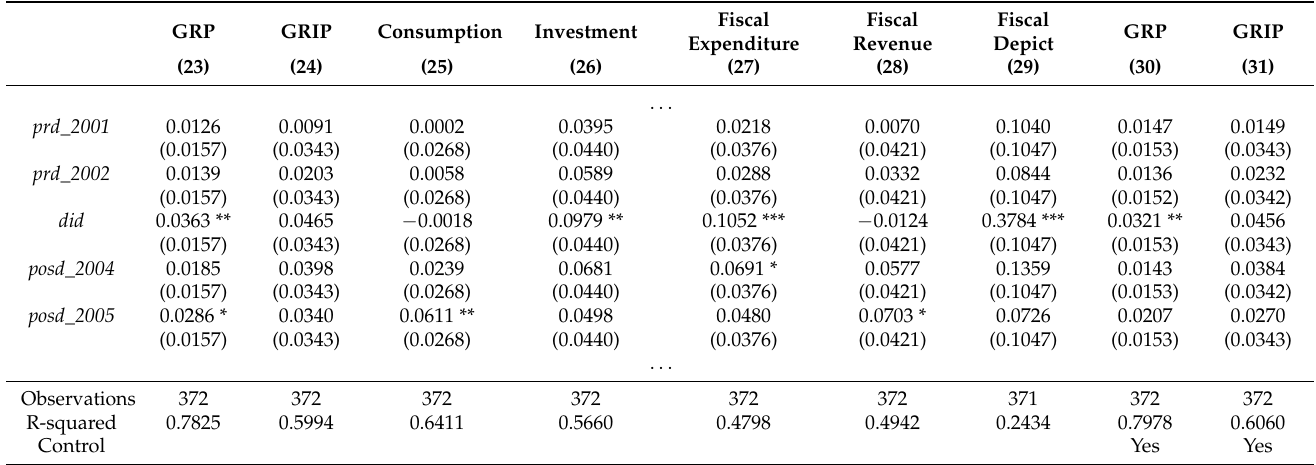
Table 4. Dynamic Mechanism Identification.